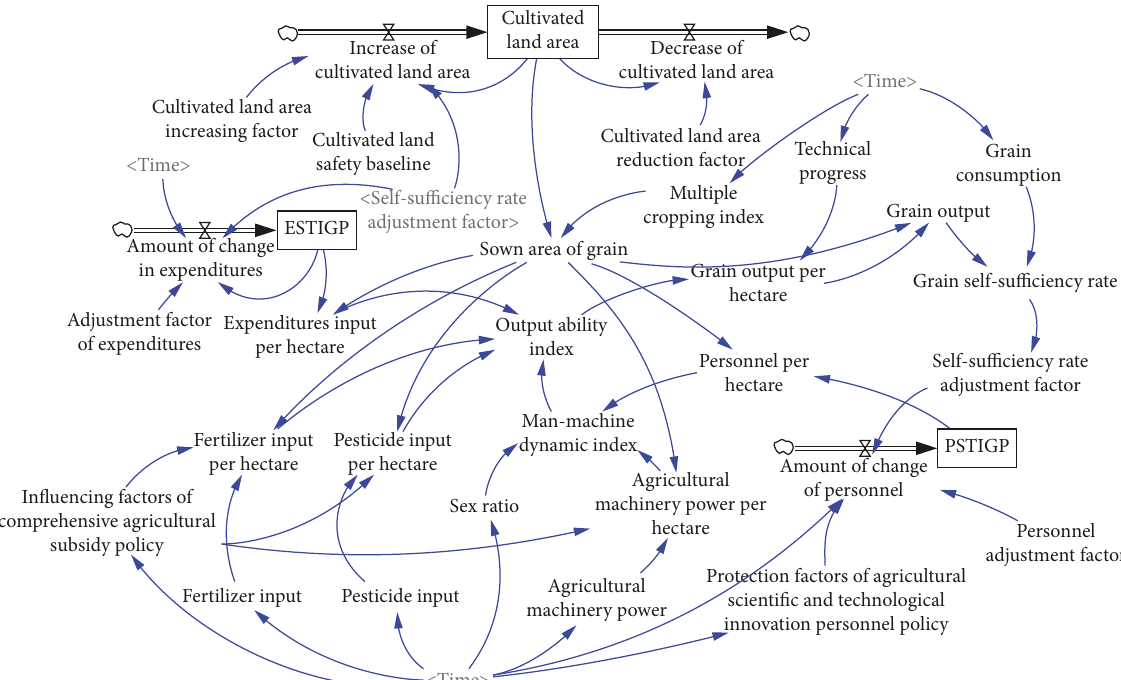
Figure 2: Feedback loop diagram between main variables of the